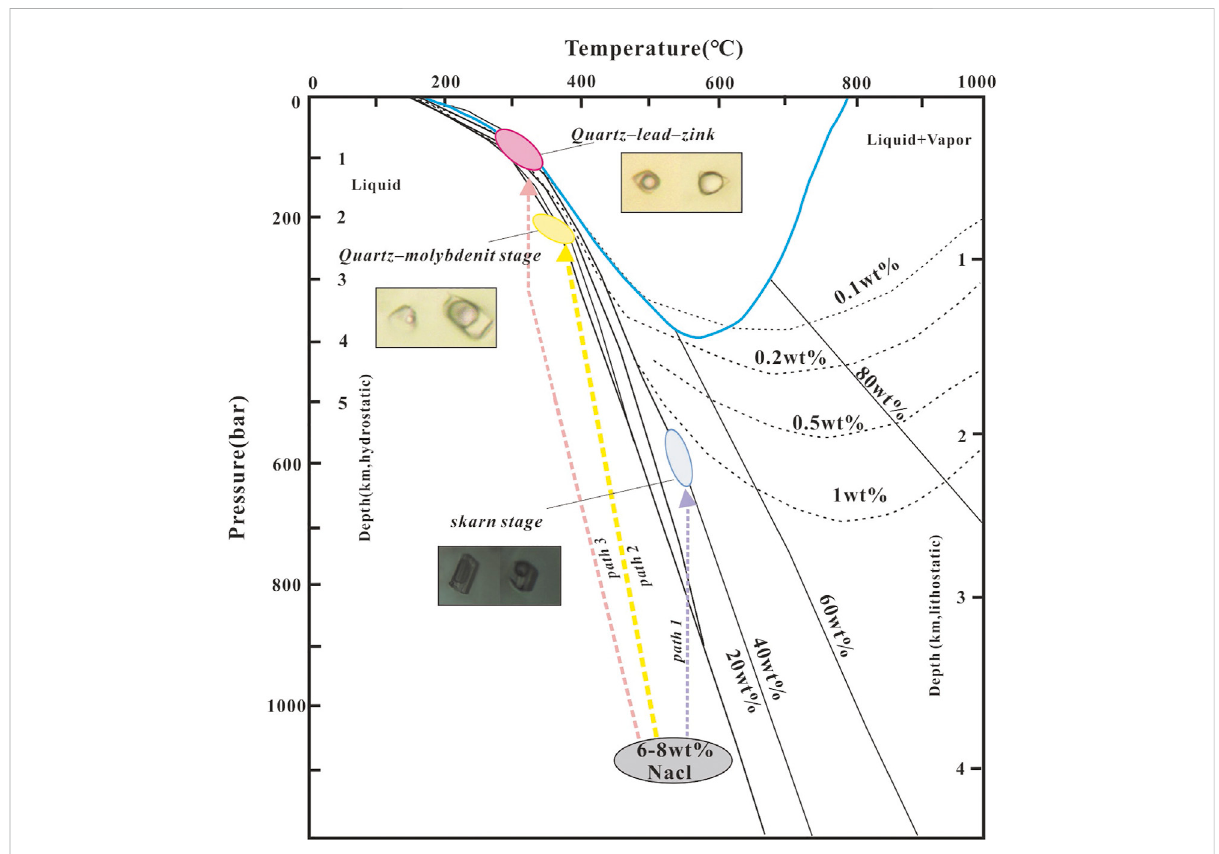
FIGURE 14 Fluid evolution paths of the Shibaogou Mo (Mo) deposit (after Meinert et al., 2003; Shu et al., 2013; Peng et al., 2016). The initial fl uids exsolved from the deep magma chamber are assumed supercritical magmatic fl uids with an initial salinity of 6 – 8 wt% NaCl equiv. (Hedenquist and Lowenstern,1994).These fl uidsfollowedthreedifferentcooling paths:(1)path1showsthe fl uidtrajectory formingskarn(513 – 550 ° C,580 – 650 bar, and 2.19 – 2.45 km under a lithostatic condition); (2) path 2 shows the trajectory forming Mo-dominated mineralization (324 – 387 ° C, 180 – 250 bar, and 0.49 – 0.94 km under a hydrostatic depth); (3) path 3 shows the trajectory forming quartz – galena – sphalerite stage of mineralization (303 – 347 ° C, < 150bar, and < 0.56 km under a hydrostatic depth). For details see